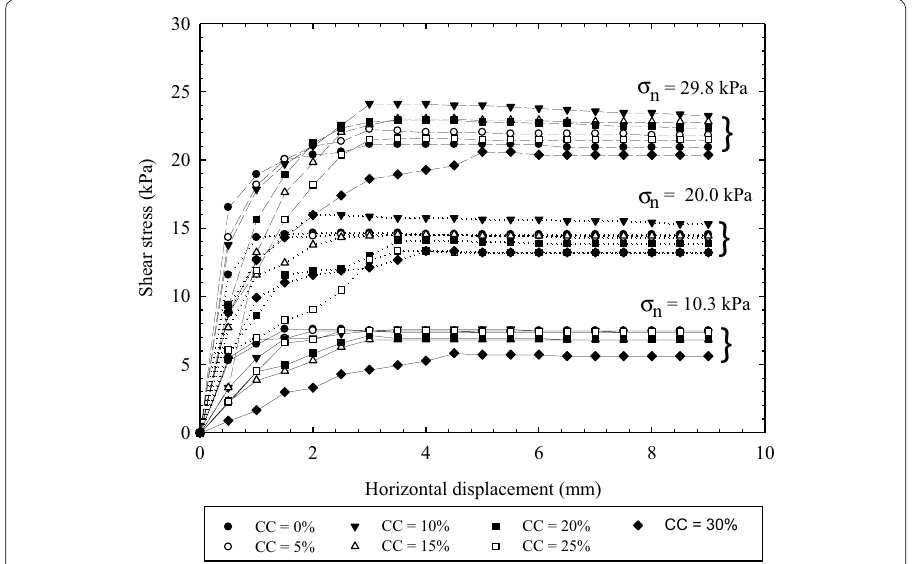
Fig. 6 Horizontal displacement versus shear stress according to clay content and normal stress (*CC denotes clay